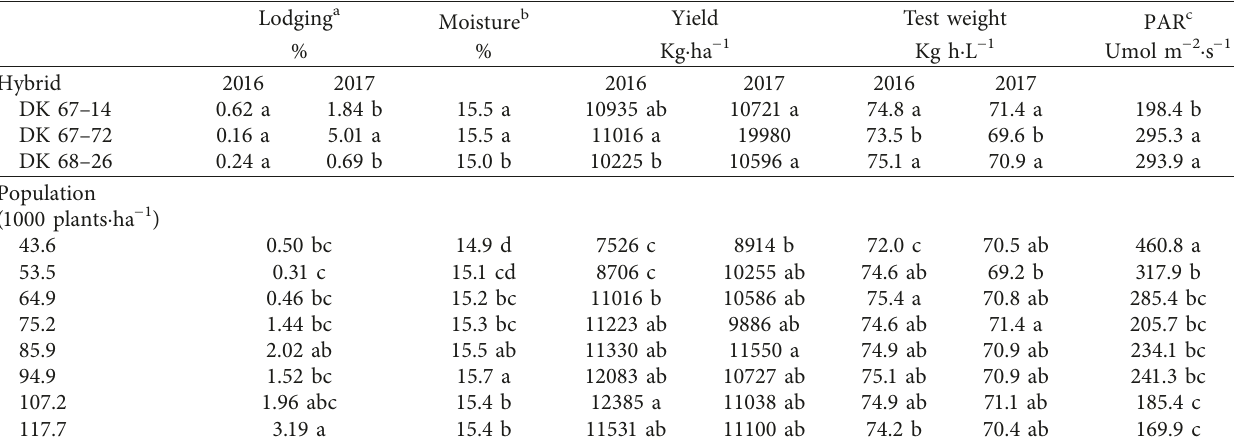
Table 4: Stalk lodging, moisture, grain yield, test weight, and photosynthetically active radiation readings of the three hybrids at the various plant populations in 2016–2017.